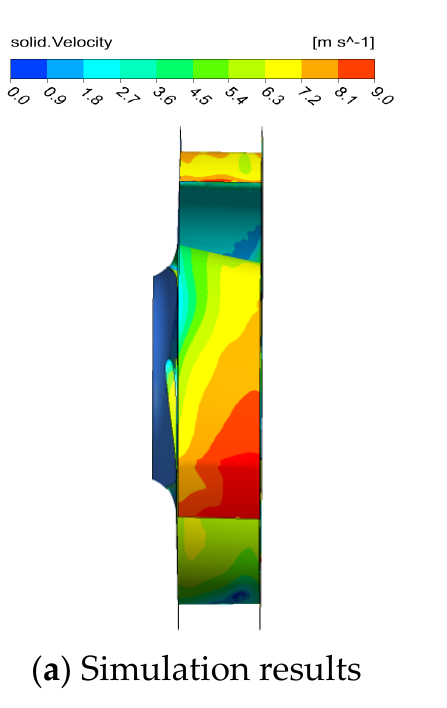
Figure 24. ( a , b ) Comparison of impeller inlet wear.